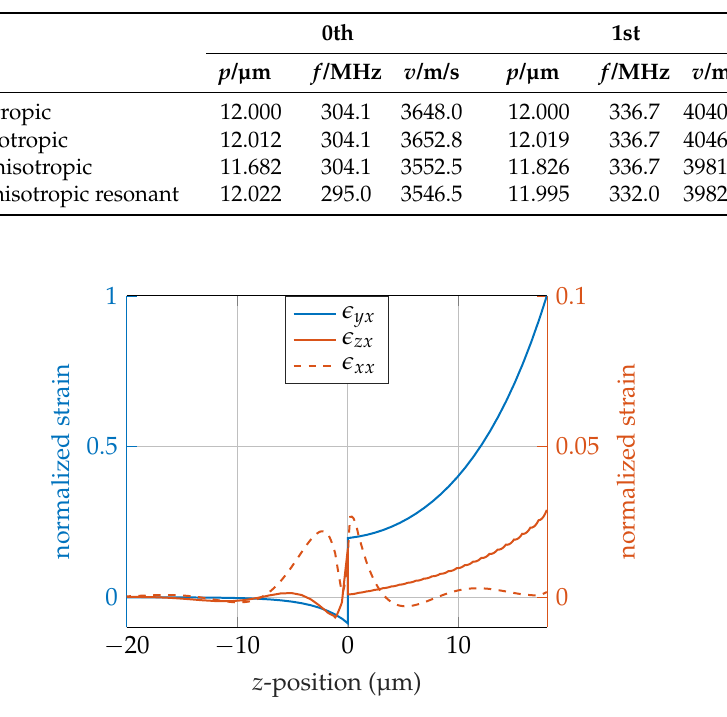
Figure 4. Comparison of strain tensor components of a SAW sensor at the first mode with 18µm guiding layer thickness and substrate for z < 0. The components are normalized to the maximum of the main shear component (cid:101) yx . The magnitude of the components (cid:101) zx and (cid:101) xx are shown on the right